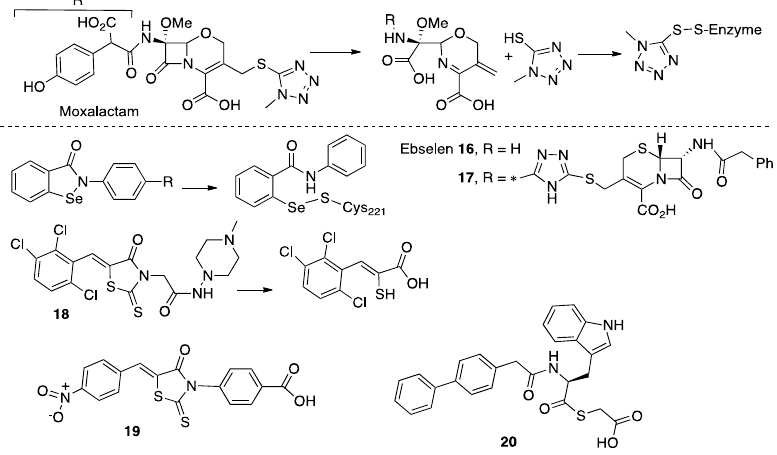
Figure 8. Prodrugs and irreversible compounds proposed as MBL inhibitors.